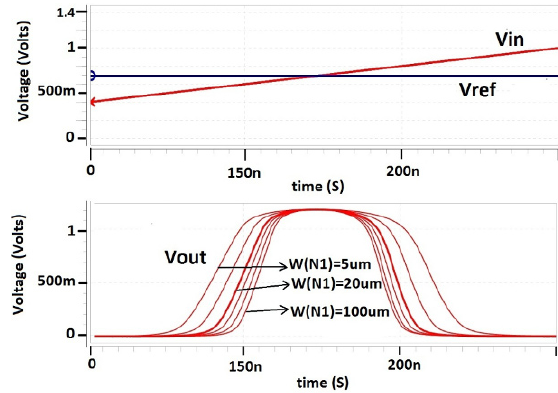
Figure 4. Effectofvaryingthewidthofactivedevicesonthedetection window.